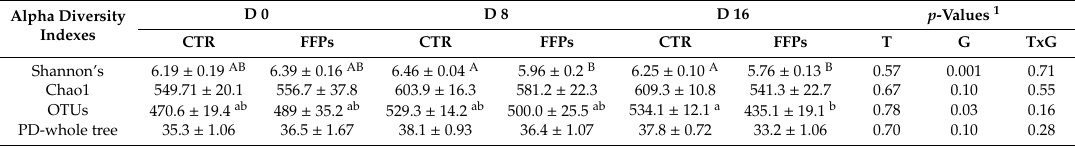
Table 1. Summary of next generation sequencing data and e ff ect of FFP-based diet on diversity and abundance indexes at each sampling time ( ± standard error of the mean) in post-weaning piglets.